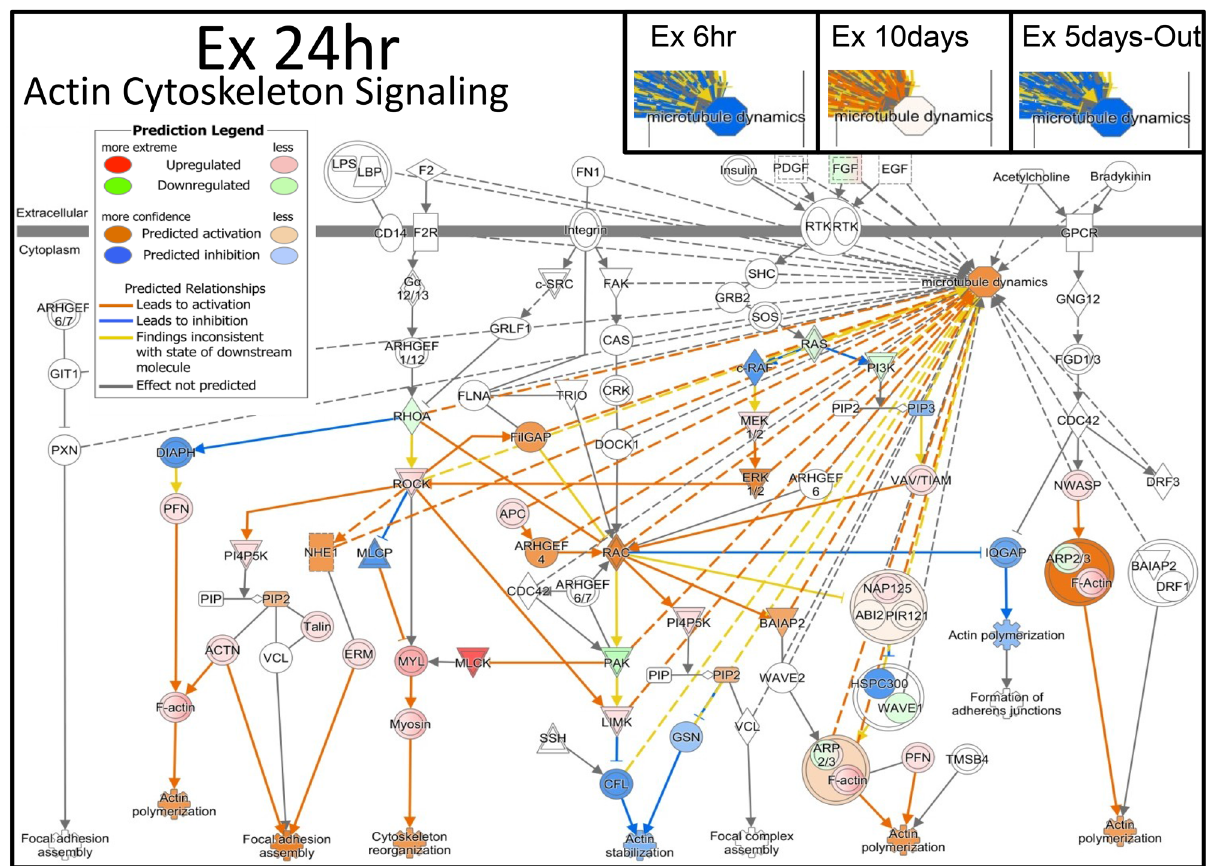
Figure 4. Ingenuity pathway analysis (IPA) of actin cytoskeleton signaling in the Xenopus laevis whole brain after exposure to the predatory salamander larva, Hynobius lichenatus . Actin cytoskeleton signaling after 24 h of predation (24 h group). The microtubule dynamics shown in the boxes labeled Ex6hr (after 6 h of predation), Ex10days (after 10 h of predation), and Ex5days-Out (after 5 days of predation, followed by 5 days with no predation) in the top right corner, were predicted from the ac t in cytoskeleton signaling. The microtubule dynamics in Ex24hr were predicted to be up regulated in the signal transduction map. Blue indicates downregulation and orange indicates upregulation of the microtubule dynamics, compared with the control. The predictions were performed using two statistical measures, an overlapping p ‐ value, and an activation z- score, that were computed for each potential transcriptional regulator. This figure was created using Ingenuity pathway analysis (IPA) version 2.1, QIAGEN; (https ://www.qiage nbioi nform atics .com/produ cts/ingen uityp athwa y-analy